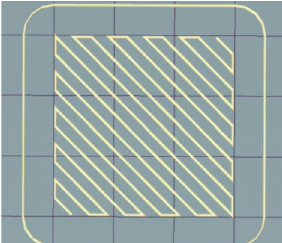
Fig. 2 Square spiral pattern for printability test